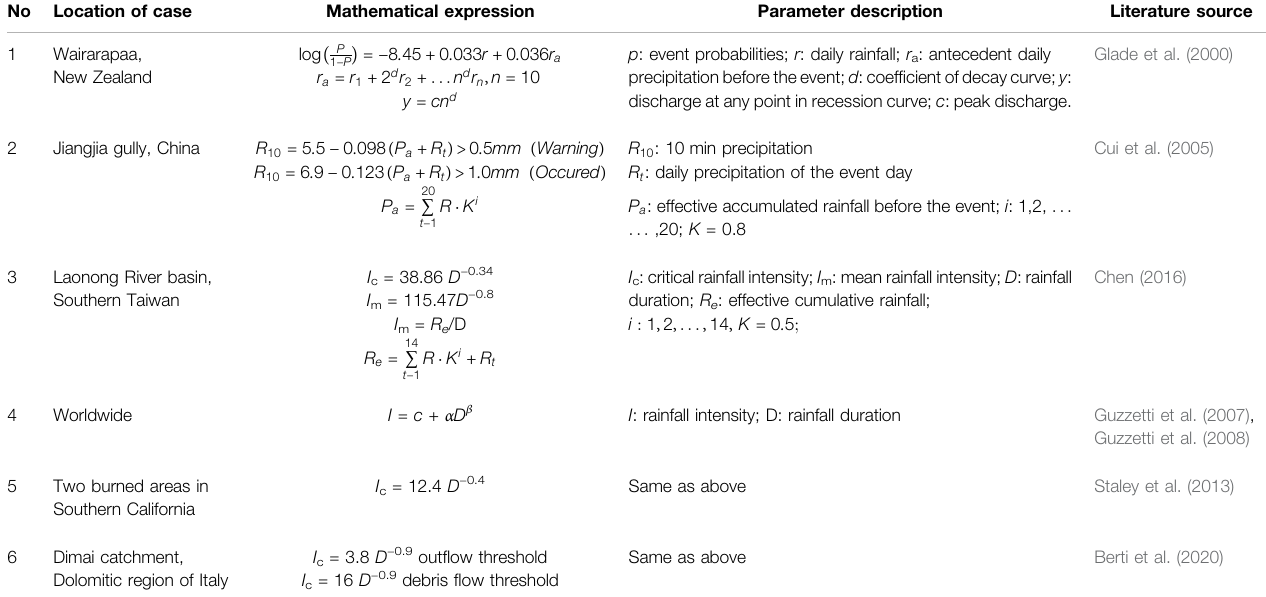
TABLE 2 | Some typical discrimination formulas of debris fl ow occurrence based on the rainfall indicator method. No Location of case Mathematical